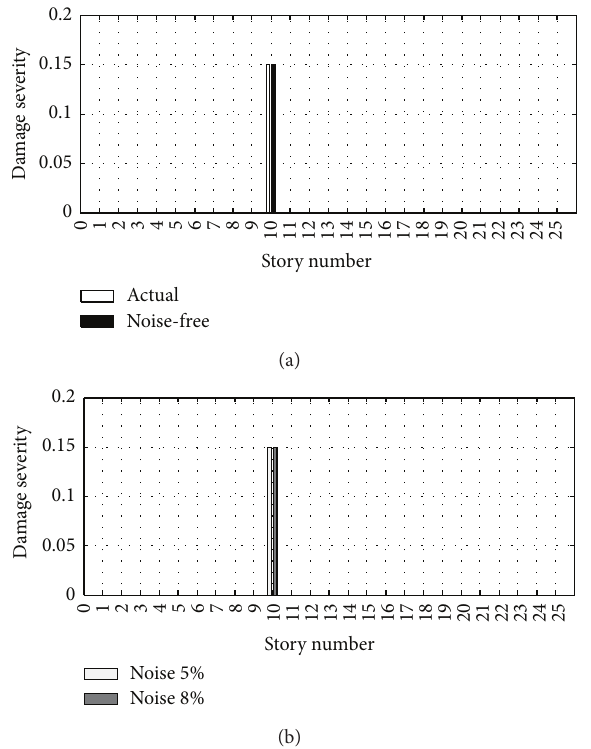
Figure 14: Damage detection results in the 25-story shear frame for scenario I.